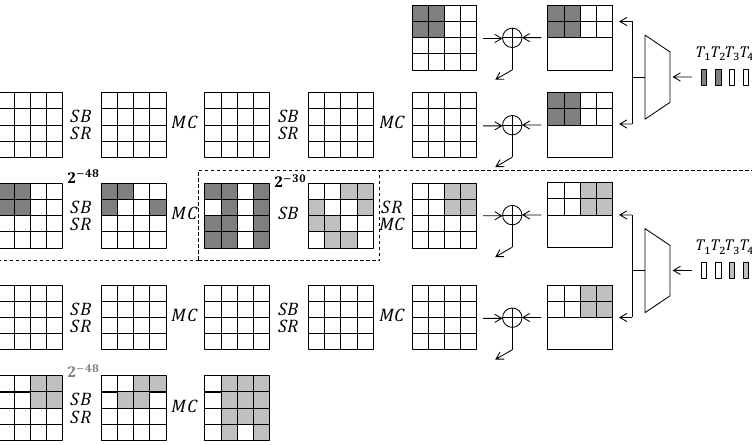
Figure 9: TweAES : Differential Trails for Boomerang Attacks. The cells filled with black and gray represent active byte positions in E 0 and E 1 ,